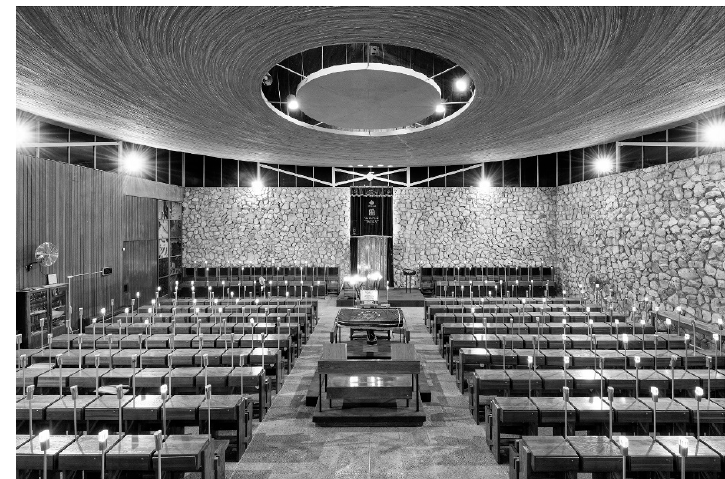
Figure 3. The Central Synagogue, Nazareth Illit. Interior view facing the bimah and the Torah Ark. Eli Singalovski, Nazareth Illit #1 , 2018. Archival pigment print, 100 cm × 67 cm . Used with permission .